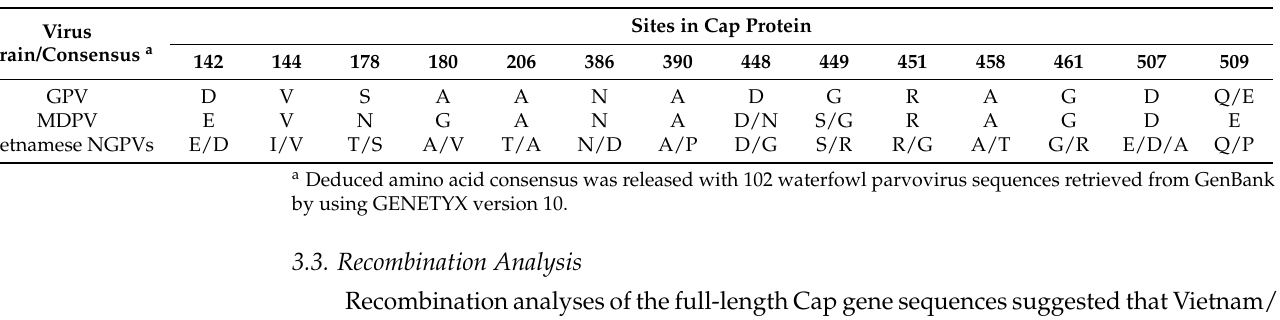
Table 6. Amino acid substitutions in Cap protein of Vietnamese NGPV strains.